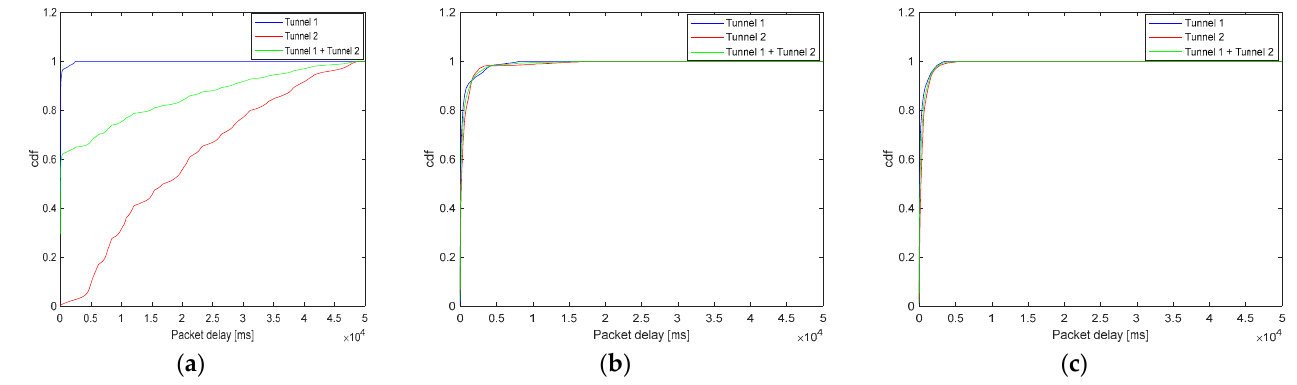
Figure 15. The Cumulative Density Functions of the packet delays on the aggregated virtual tunnels when 2 APs and different user clustering algorithms are used: ( a ) The cdfs of the packet delays when no user clustering algorithm is used; ( b ) The cdfs of the packet delays when the non-cooperative user clustering algorithm is used; ( c ) The cdfs of the packet delays when the cooperative user clustering algorithm is used.